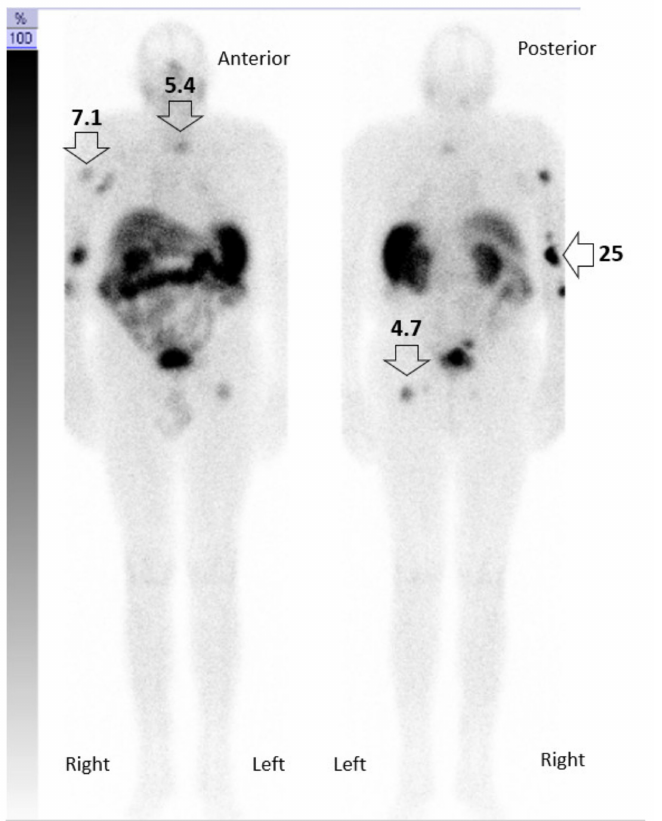
Figure 6. Radiation absorbed dose per PRRT in patient A. Image of the integral activity through time (MBq/min) indicating the local energy deposition (Gy). As an example, the delivered dose in Gy (indicated as numbers above arrows) for one PRRT treatment is